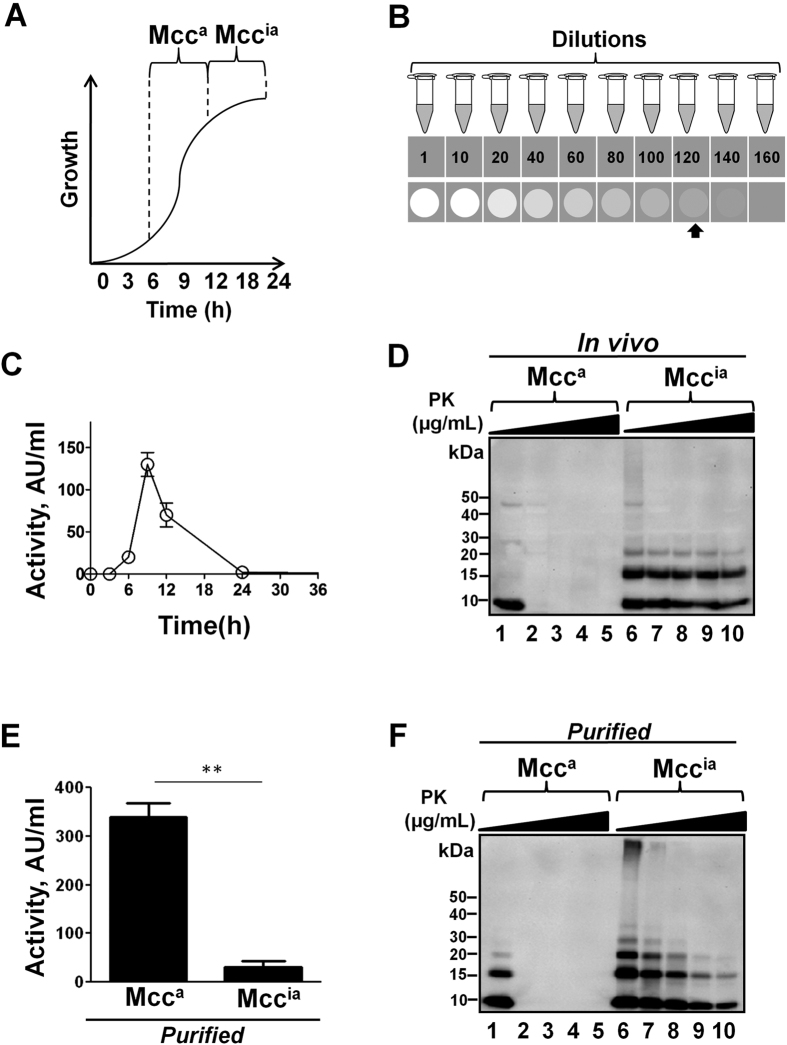
Two functionally and biochemically distinct forms of Mcc.(A) A schematic diagram of the natural production of two forms of microcin at different stages of the bacterial growth phase; Mcca (active form of Mcc) and Mccia (inactive form of Mcc). (B) A scheme of the critical dilution method (CDM) to measure Mcc bacteriotoxin activity. In brief, samples were centrifuged and supernatants were laid onto LB agar plates overlaid with Mcc-sensitive E.coli. After 16 h of incubation at 37 °C, the activity of Mcc in the last dilution that gave detectable inhibition (signal approximately 2-times above the background levels as indicated by an arrow) was determined and expressed in arbitrary units(AU)/ml. C: Typical changes on Mcc activity during different stages of culture growth. Mcc producing bacteria were grown in minimal medium at 37 °C. Aliquots were removed periodically, and activity was measured by CDM (see “Materials and Methods”). Activity was measured in duplicate samples and error bars indicate standard deviation (S.D). (D) Structural changes of Mcc reflected by differences on resistance to proteolytic degradation. Immunoblots of PK-treated aliquots of culture at the exponential and stationary phase, containing Mcca (9 h in culture) and Mccia (24 h in culture), respectively. Samples in Lanes 2-5 and 7–10, were treated with increasing concentrations of PK (1, 10, 100 and 1000 μg/ml). Samples in lanes 1 and 6 were left untreated. E: The activity of purified Mcca (400 μg/ml) before and after aggregation into Mccia at 37 °C for 24 h was measured by CDM. Error bars indicate S.D. The differences were statistically analyzed by the student t-test (** P = 0.0052). F: Acquisition of protease-resistance upon in vitro conversion of Mcca into Mccia. Aliquots of purified Mcca (t = 0 h) and after conversion into Mccia (t = 24 h) were subjected to the same treatment with PK as described in panel D. Mcca (lanes 1-5) and Mccia (lanes 6-10). Samples in Lanes 2-5 and 7-10, were treated with increasing concentrations of PK (1, 10, 100 and 1000 μg/ml). Samples in lanes 1 and 6 were left untreated.